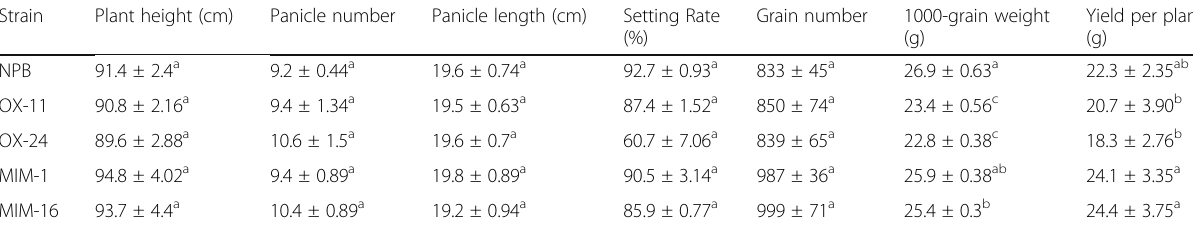
Table 1 The agronomic traits of OX162 and MIM162 Strain Plant height